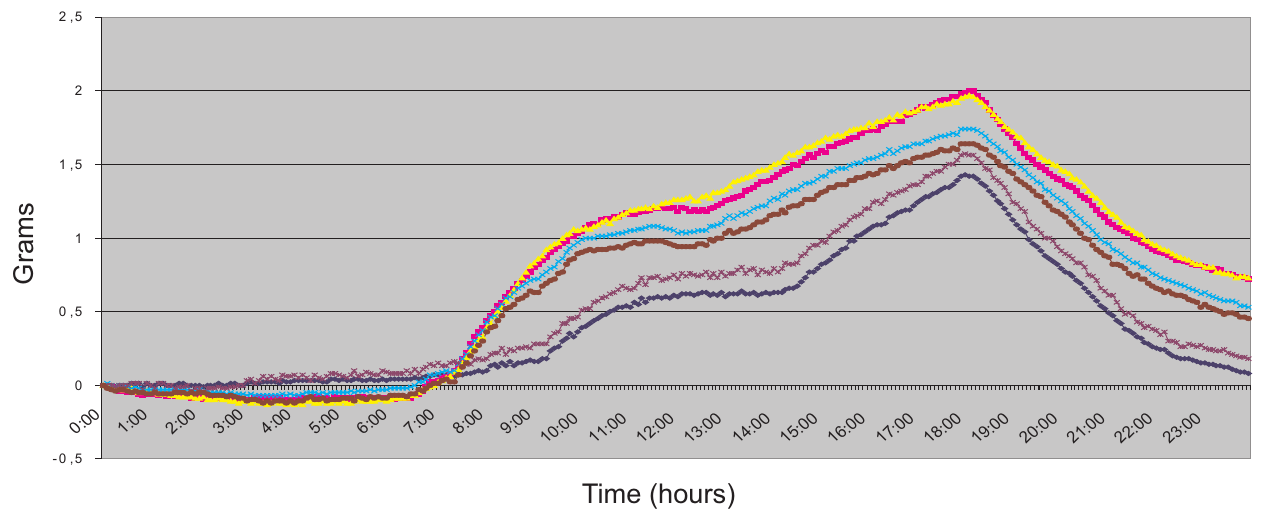
Figure 6. Noise caused by variations in room